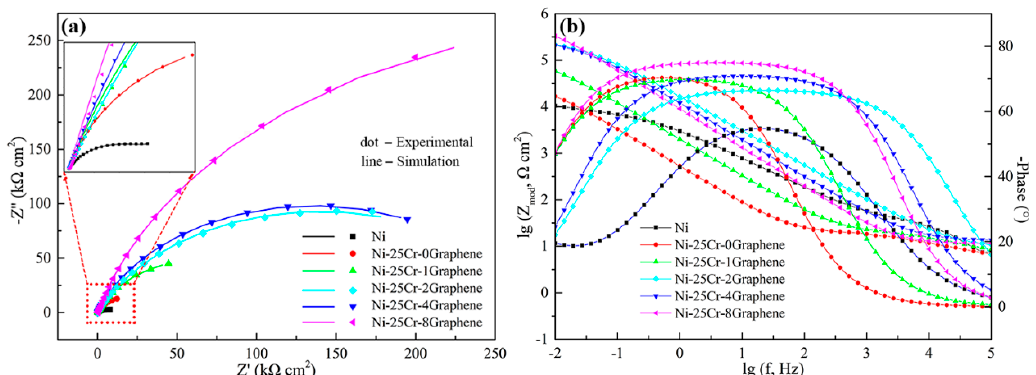
Figure 14. Nyquist plots ( a ) and Bode plots ( b ) of the Ni – Cr – graphene coatings in 3.5% NaCl solution.